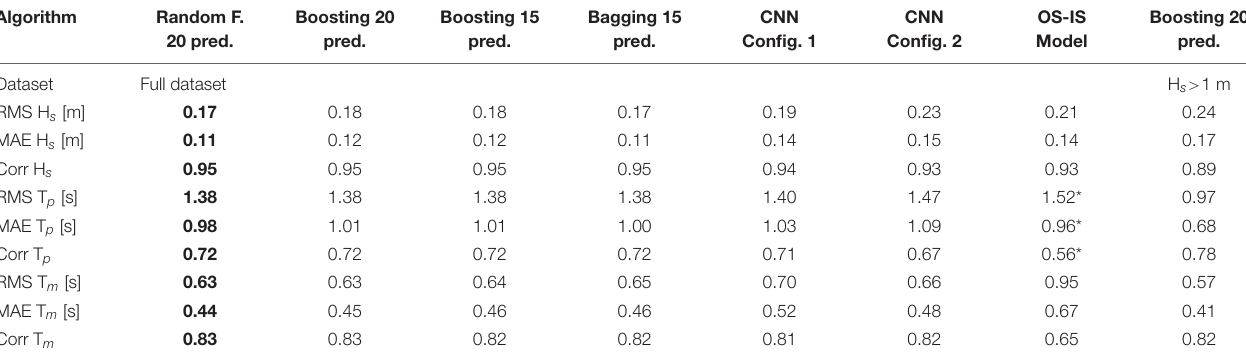
TABLE 1 | Performance of the ML models trained and validated over the data from 2014. Algorithm Random F. 20